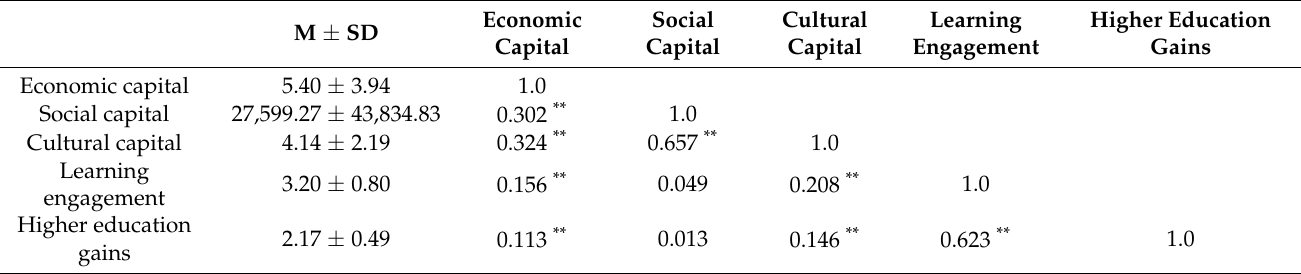
Table 2. Correlations among